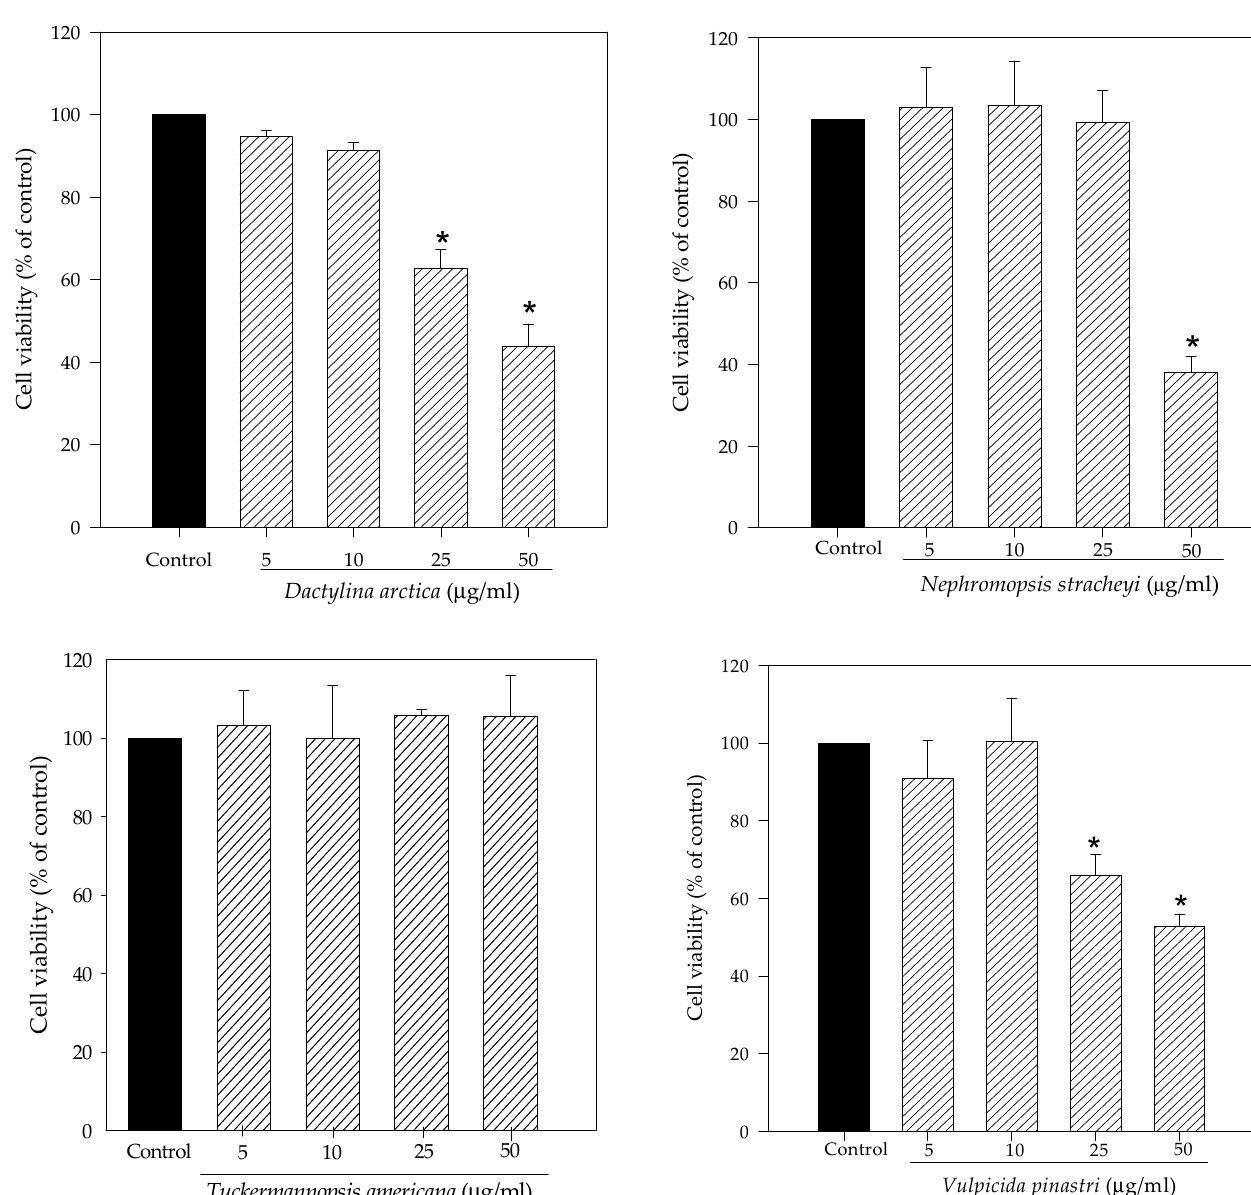
Figure 1. Effect of methanol lichen extracts of cetrarioid clade on cell viability. SH-SY5Y cells were treated with different concentrations of extracts from 5 to 50 µg/mL fo24 h. Cell viability was determined using MTT assay. Results are expressed as mean ± standard deviation (SD) (triplicate experiments). * p < 0.05 versus control.